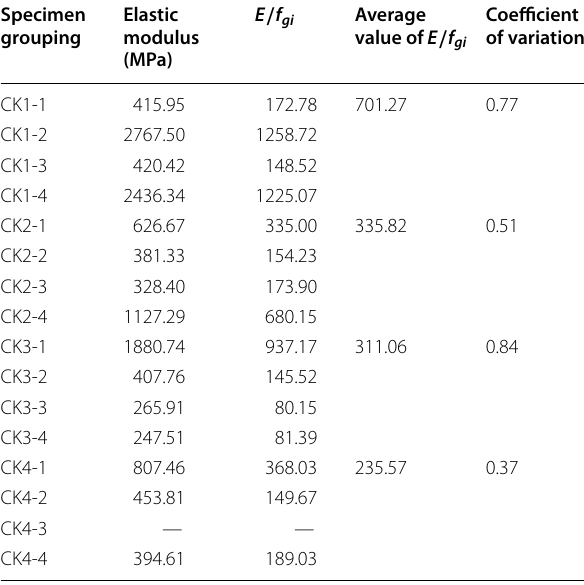
Table 7 Elastic modulus of CNACBM. Specimen grouping